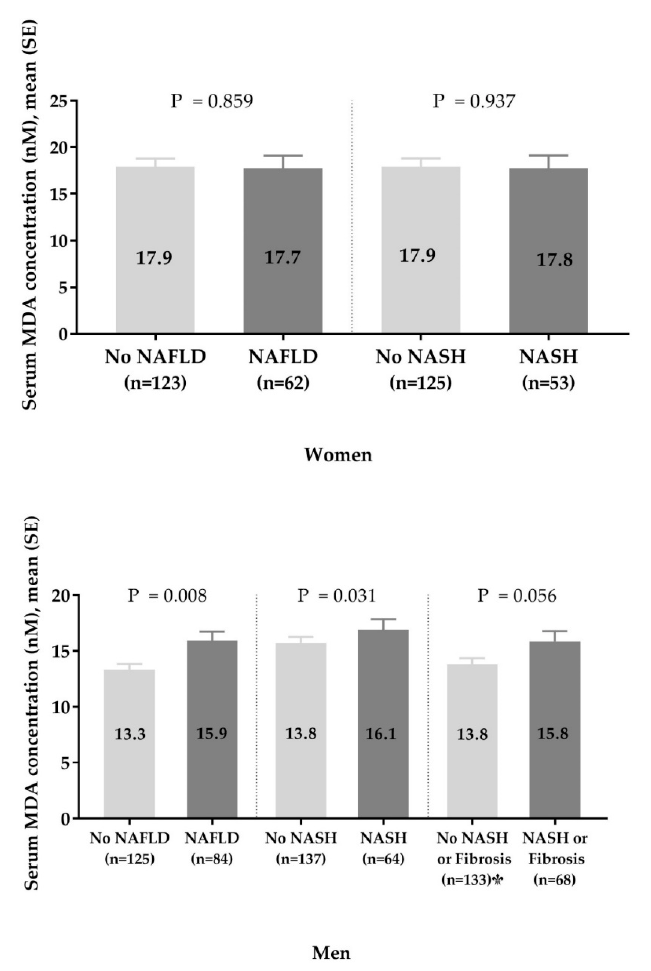
Figure A1. Mean serum MDA levels [ ± standard error (SE)] across non-alcoholic fatty liver disease (NAFLD) and steatohepatitis (NASH) diagnosis, stratified by gender. (Malondialdehyde, MDA Note: Among women, there were no cases of significant fibrosis that were without NASH, thus no results are presented in this category.)